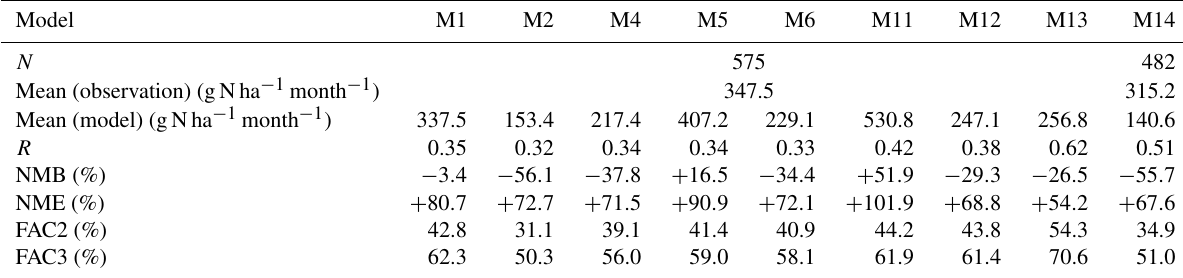
Table 4. Summary of statistical analysis of model performance for the wet deposition of N. Model M1 Mean (observation) (gNha − 1 month − 1 )